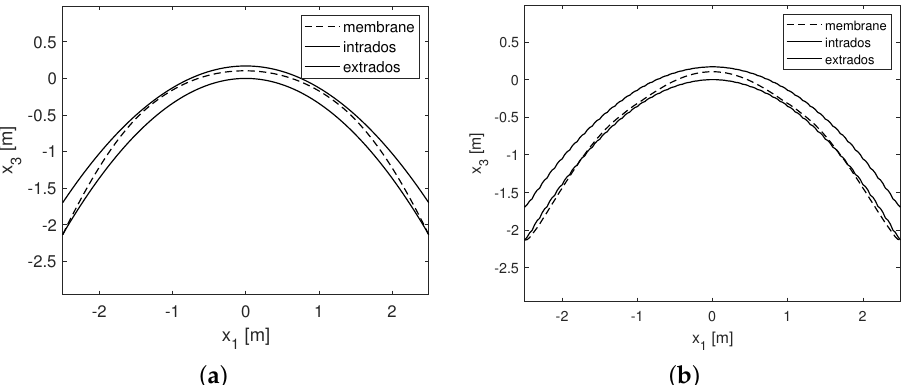
Figure 10. Sections of the vault and of the membrane surface represented in Figure 9 along x 2 = 0 ( a ) and along the diagonal x 2 = − x 1 ( b ), after optimization with respect to the shape of the stress